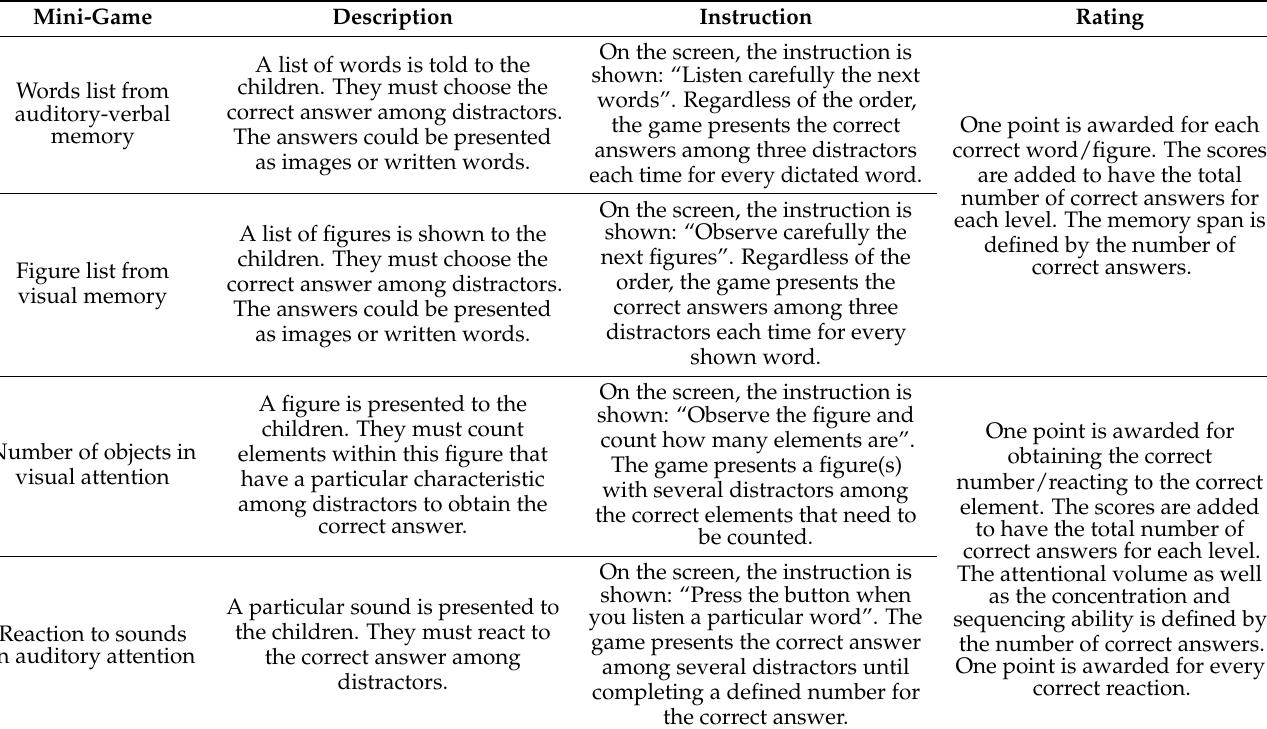
Table 2: the description, the instruction, and the rating of some mini-games are detailed. Table 2. Mini-game descriptions for face